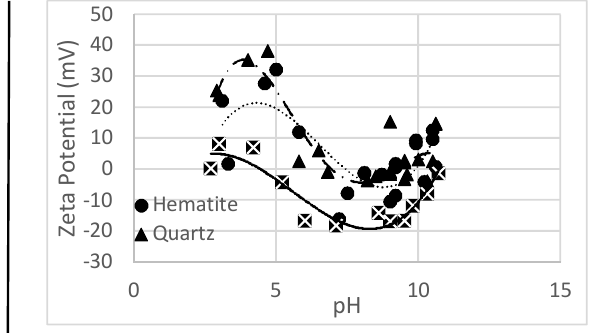
Fig. 4: ZP of Hematite, Quartz, and Kaolinite in Presence of POMI as a function of pH